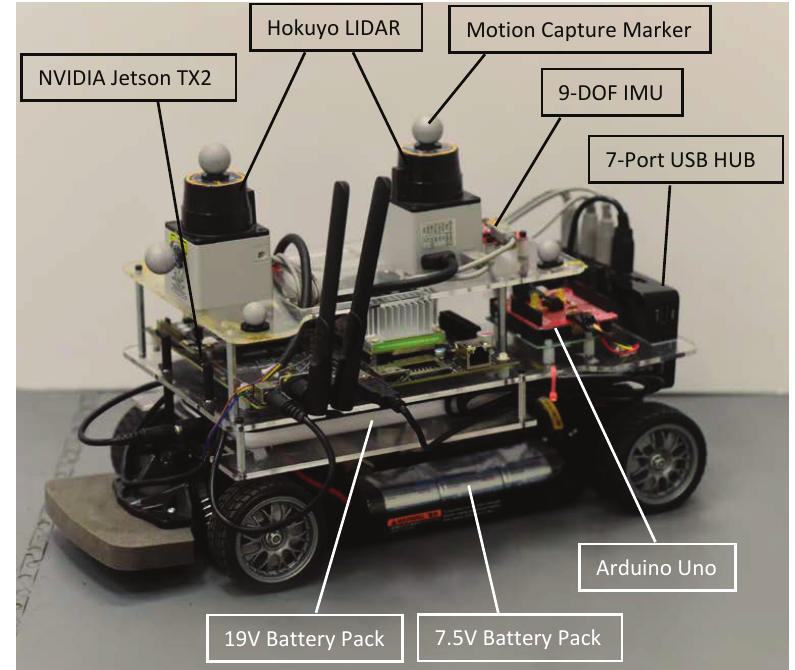
Figure 1. Picture of the PSU BOT